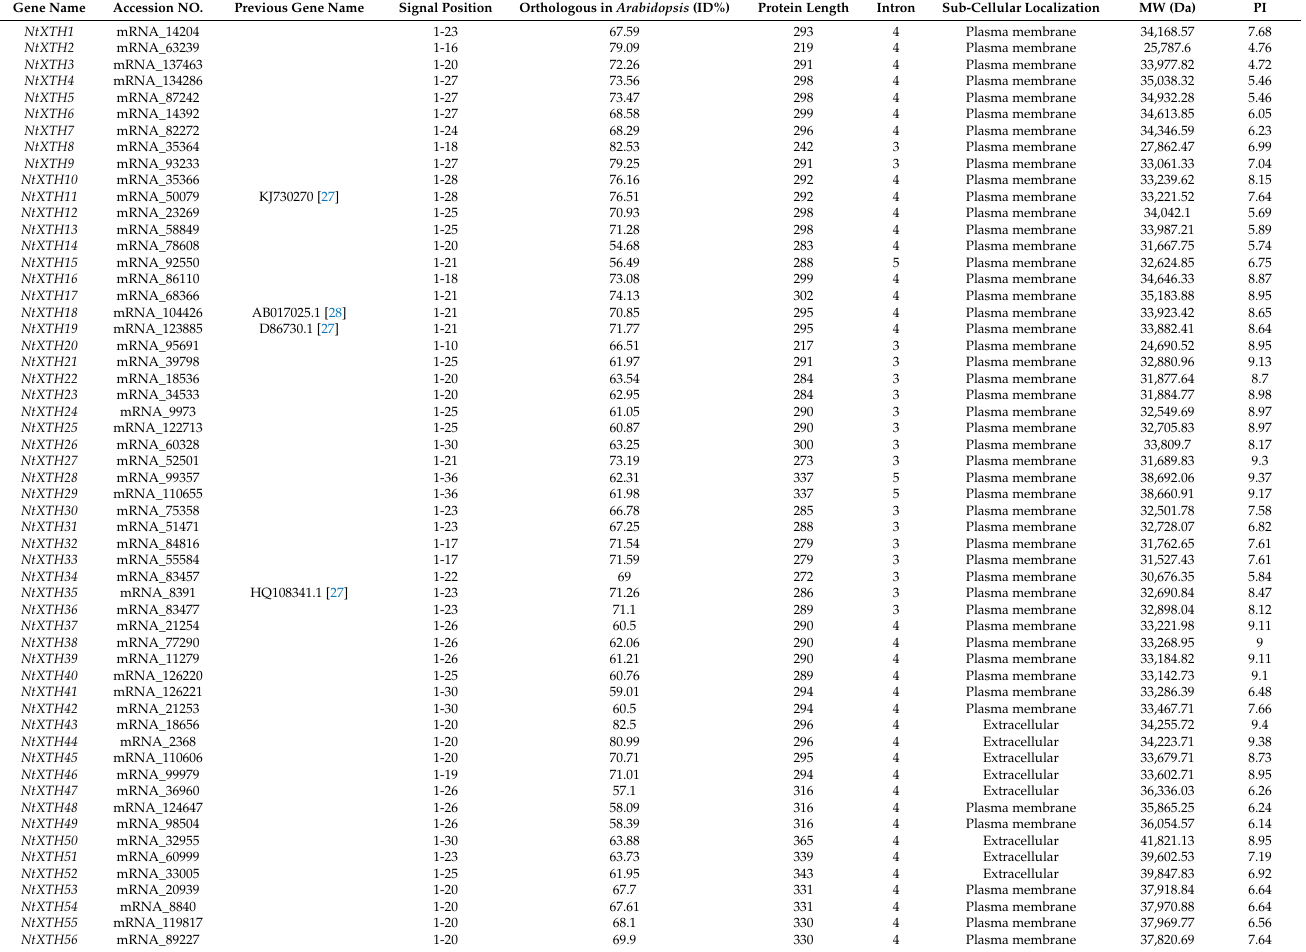
Table 1. Characteristics of fifty-six NtXTHs identified in the Nicotiana tabacum